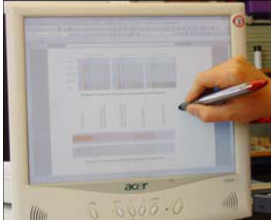
Figure 9. Using the Anoto pen on a